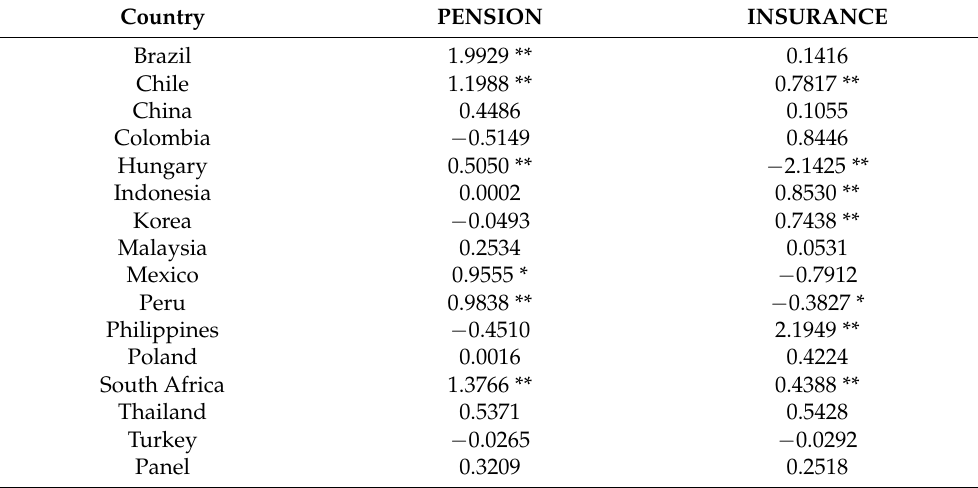
Table 5. Cointegrating Coefficient Estimation